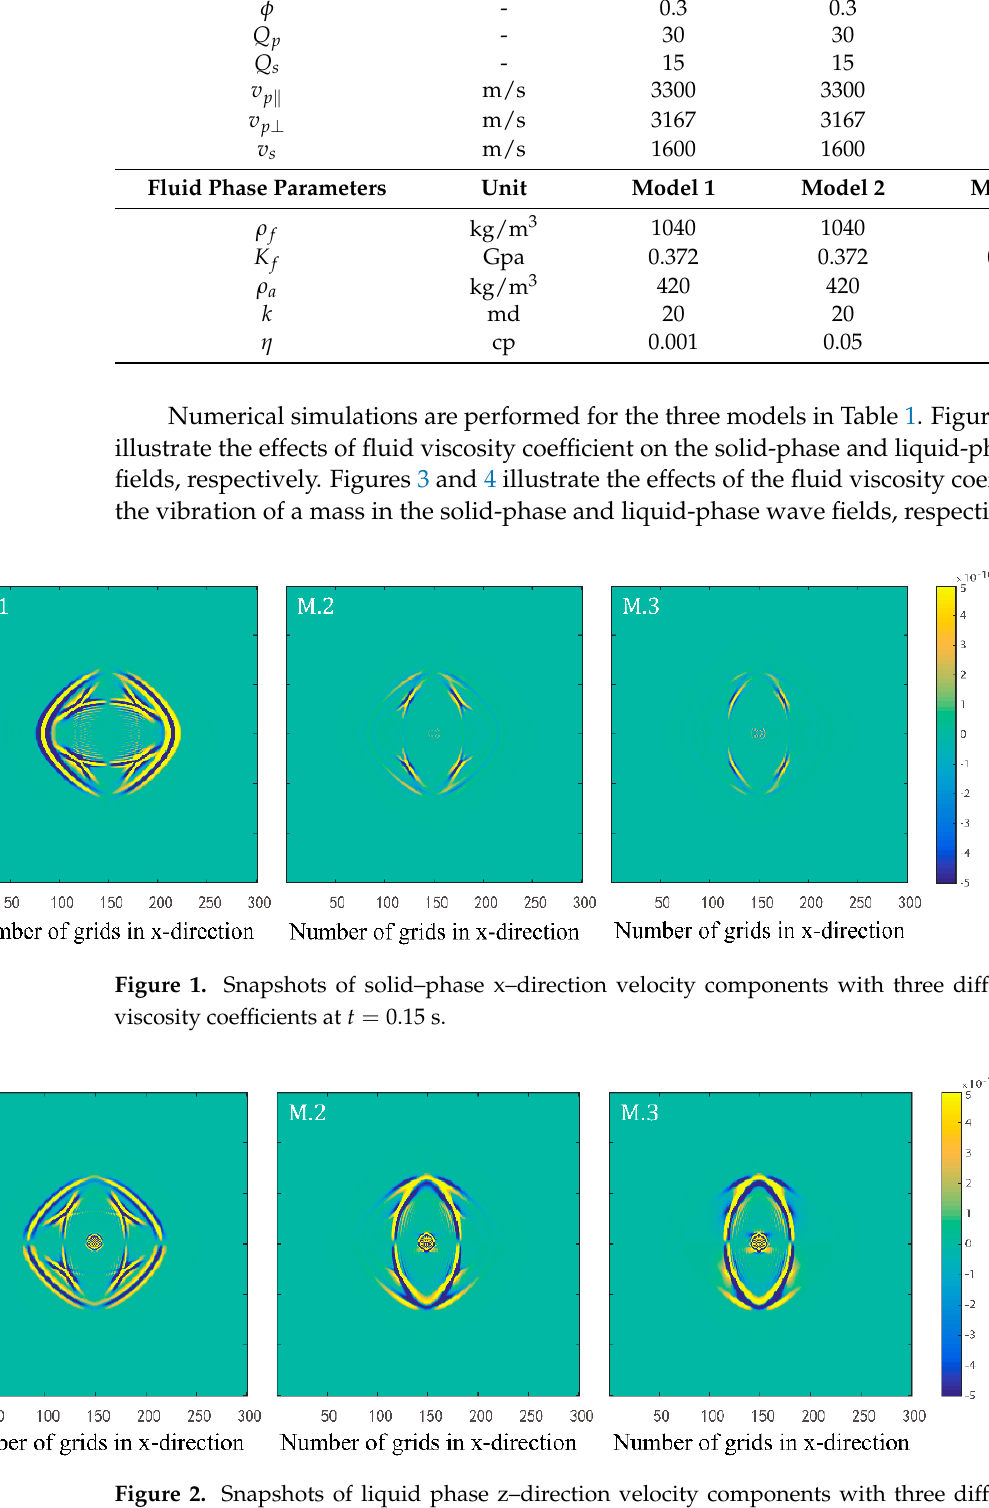
Figure 3. Comparison of solid–phase x–direction velocity components with three different fluid vis ‐ cosity coefficients at points (cid:4666)160,160(cid:4667) .